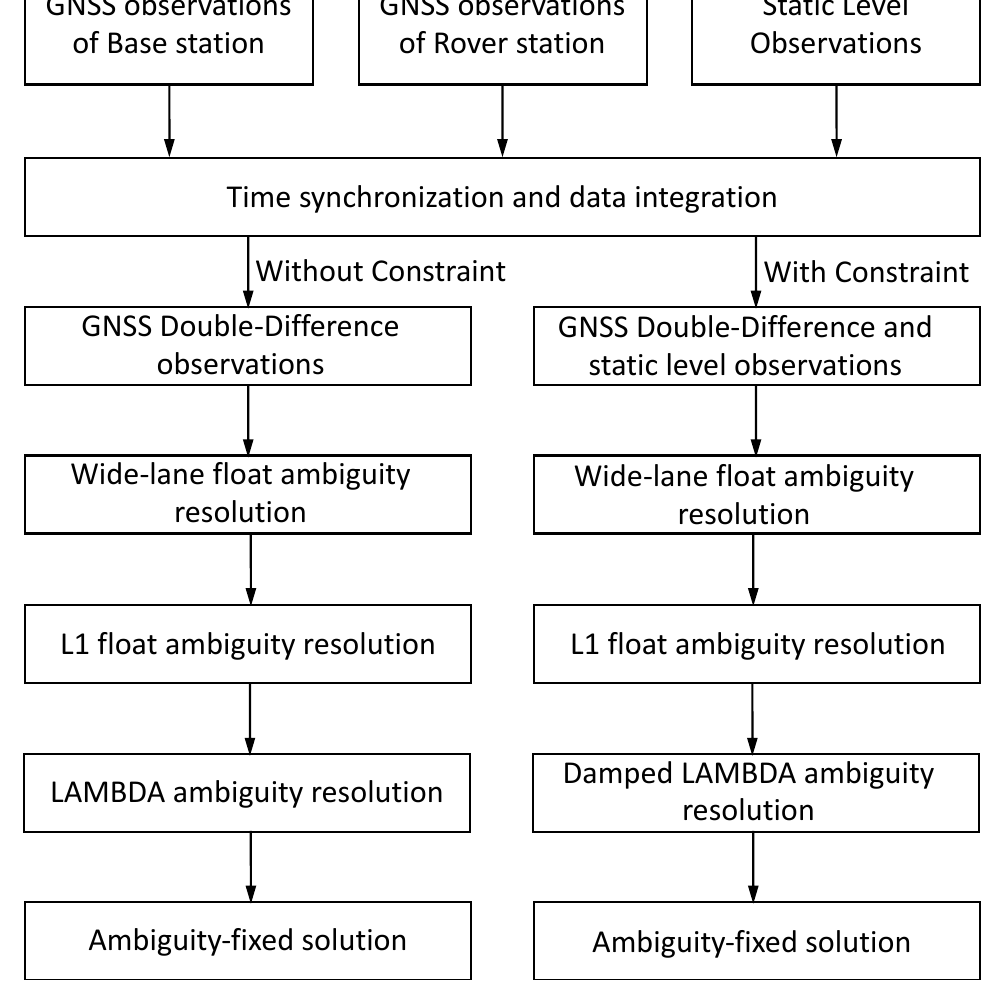
Figure 11. Flow chart of data processing.